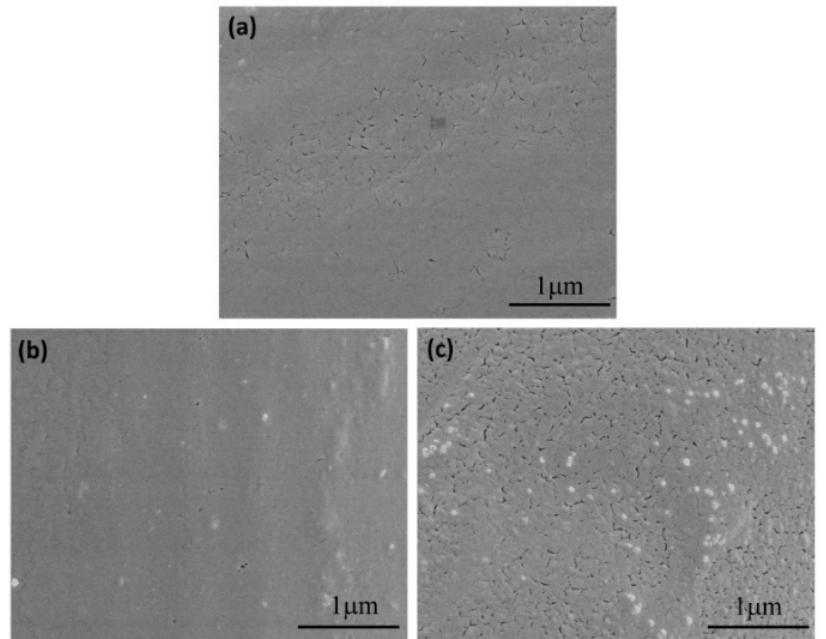
Figure 4. SEM images of surface topography of PLA nonwoven fabrics ( a ) control; ( b ) CS-Ag NPs-PLA; ( c ) DBD-CS-Ag NPs-PLA.